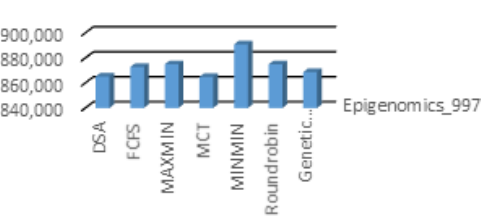
Fig. 9. Execution time required for Epigenomic997 using di®erent schedulers.